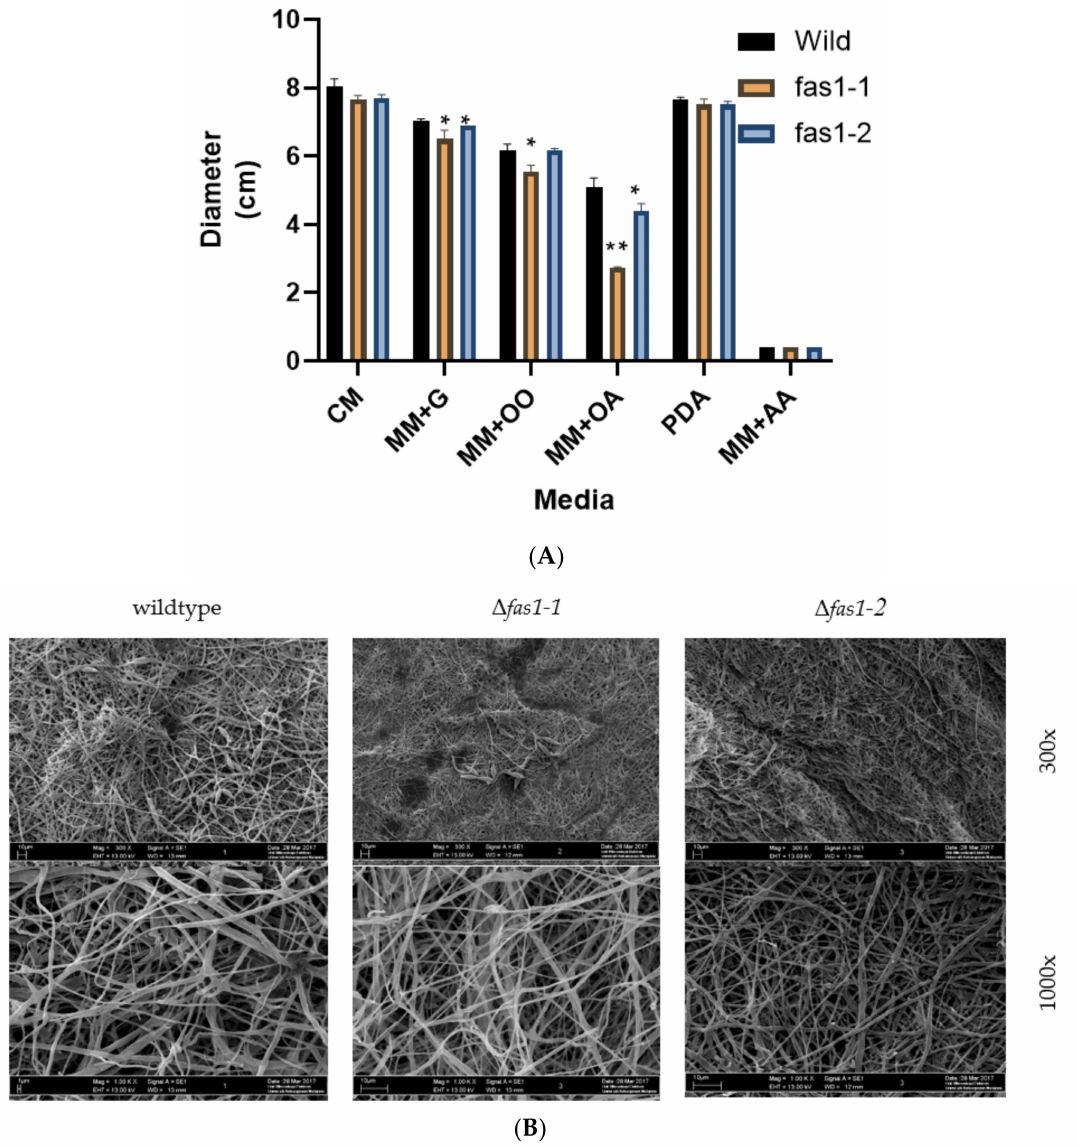
Figure 5. Growth rate and mycelial structure under scanning electron microscope (SEM). ( A ) Growth rate on di ff erent carbon source of wildtype, fas1-1 and fas1- 2 after 10 days of incubation on complete medium agar plates at 26 ◦ C. Error bars represent the standard deviation. Single asterisk represents significant di ff erence ( p ≤ 0.05). Double asterisks represent significant di ff erence ( p ≤ 0.01). ( B ) image of wildtype, fas1-1 and fas1-2 mycelium structure after 10 days of incubation on complete medium at temperature of 26 ◦ C. Magnification 300 × and 1000 × taken using